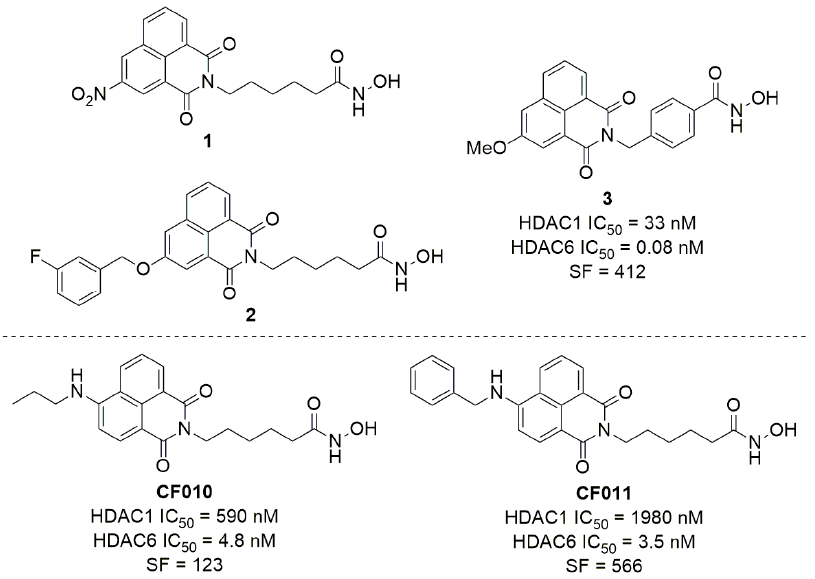
Figure 2. Top: All published examples of 3-substituted scriptaid analogues [38–40], and Bottom: selected examples of 4-substituted scriptaid analogues from our recent work [41]. No activity data for 1 and 2 has been published. Selectivity factor (SF) = HDAC1 IC 50 /HDAC6 IC 50